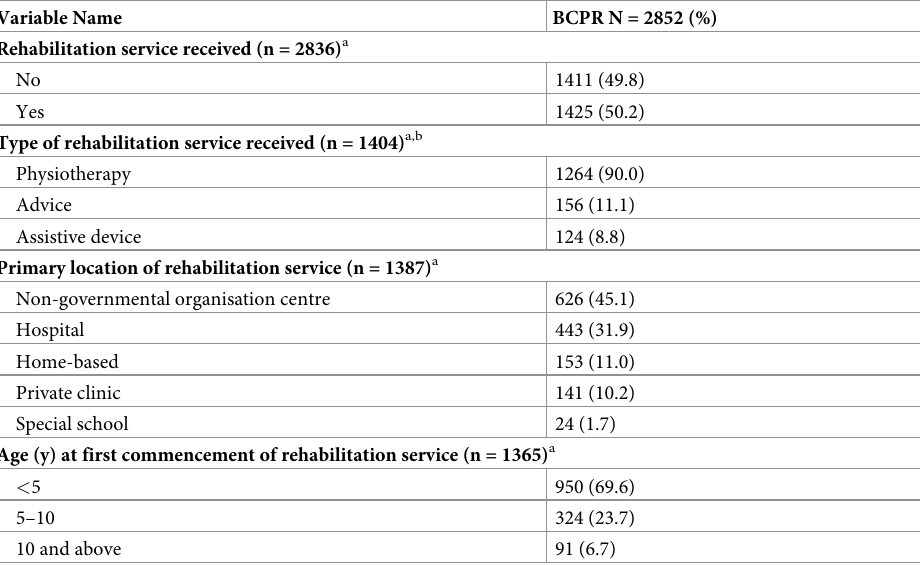
Table 2. Rehabilitation status of children with CP in the BCPR